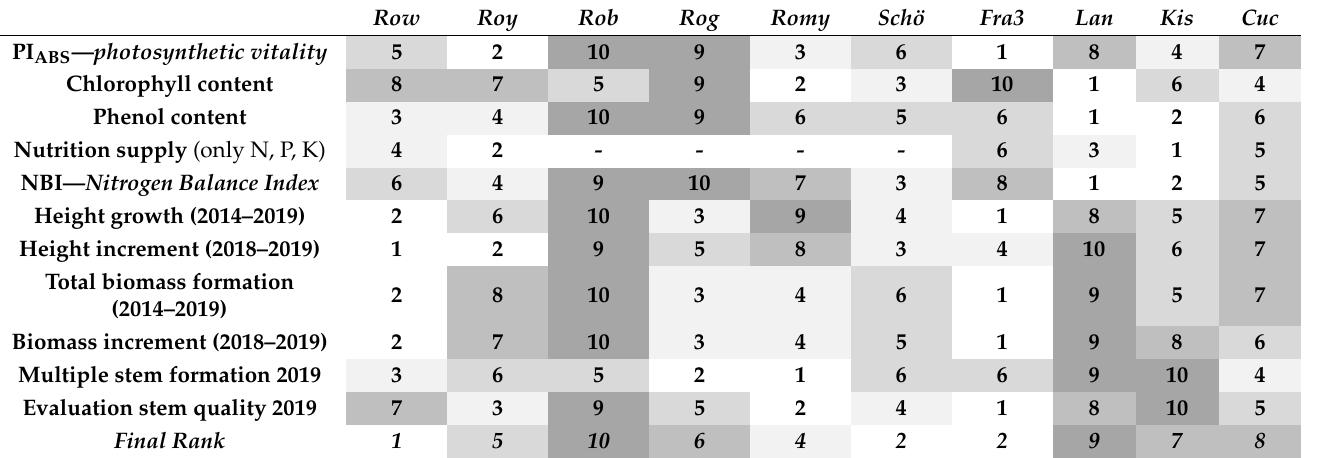
Table 7. Ranking of major plant-physiological, biomass growth and quality parameters of ten Black Locust clones and provenances. The background colour is a stylistic